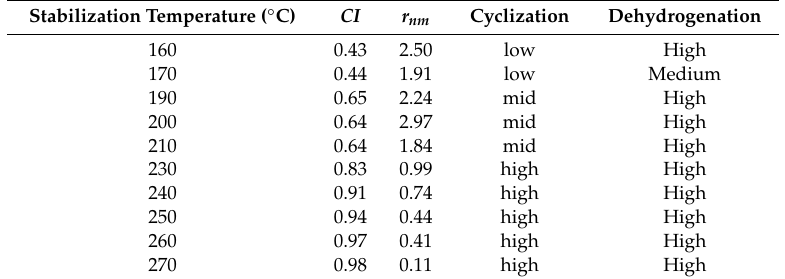
Table 2. Values of treatment r nm and cyclization index (CI) indexes measured from FTIR spectra via Lambert–Beer